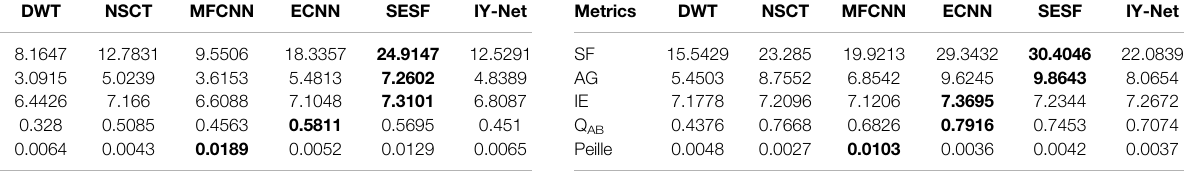
TABLE 2 | Quantitative evaluation results of infrared and visible image fusion. Metrics